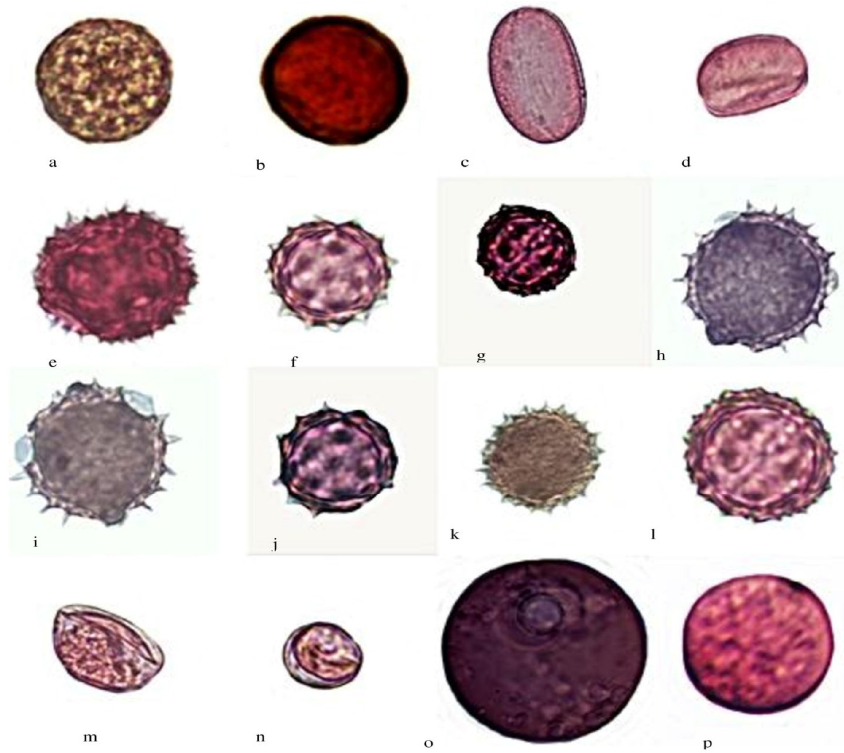
Agronomy 2023 , 13 , x FOR PEER REVIEW